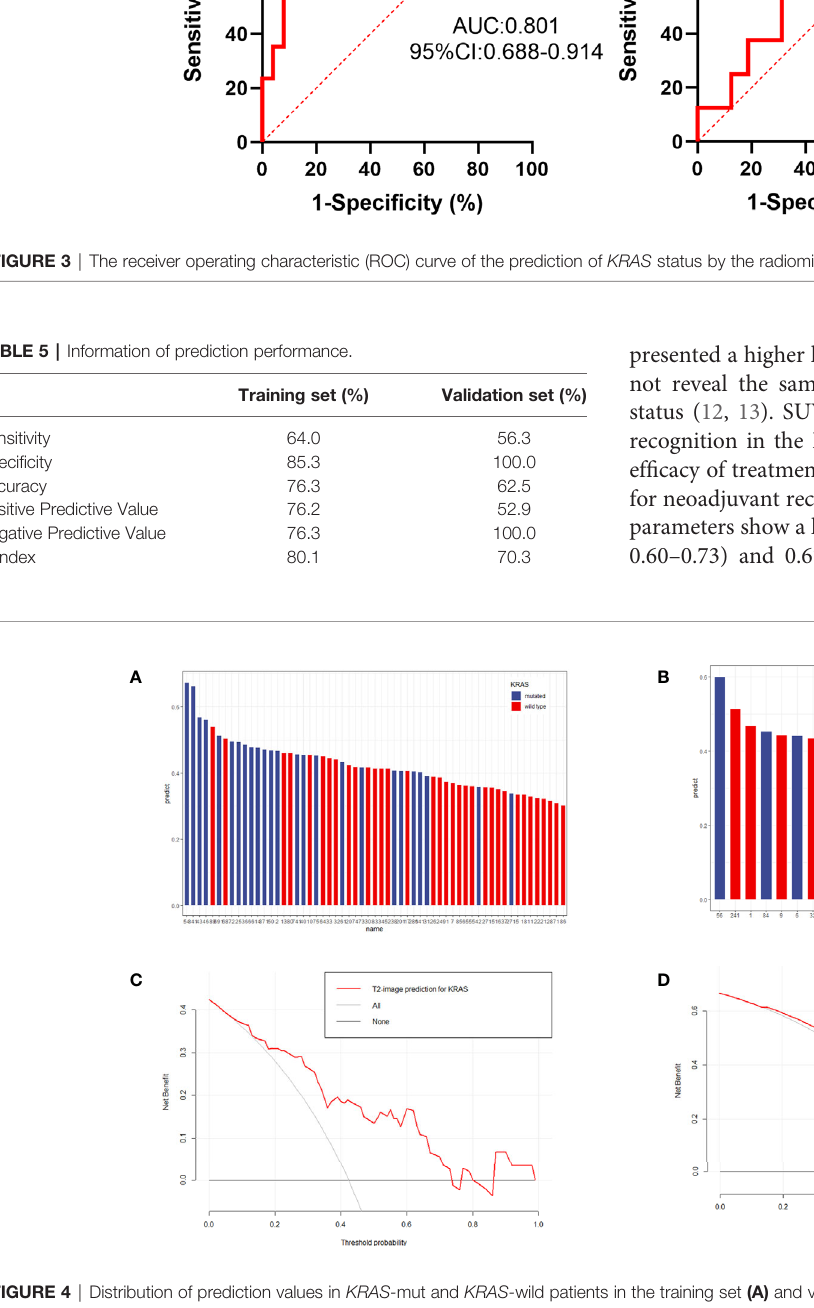
FIGURE 4 | Distribution of prediction values in KRAS- mut and KRAS- wild patients in the training set (A) and validation set (B) . The y-axis measures the calculation value of the radiomic model. The blue columns represent actual KRAS- mut patients, and the red columns represent actual KRAS-wild patients. A higher column represents a higher value calculated by the model. According to the image, KRAS- mut patients more frequently obtained higher values than KRAS- wild patients. (C , D) represented the DCA analysis for the training set and validation